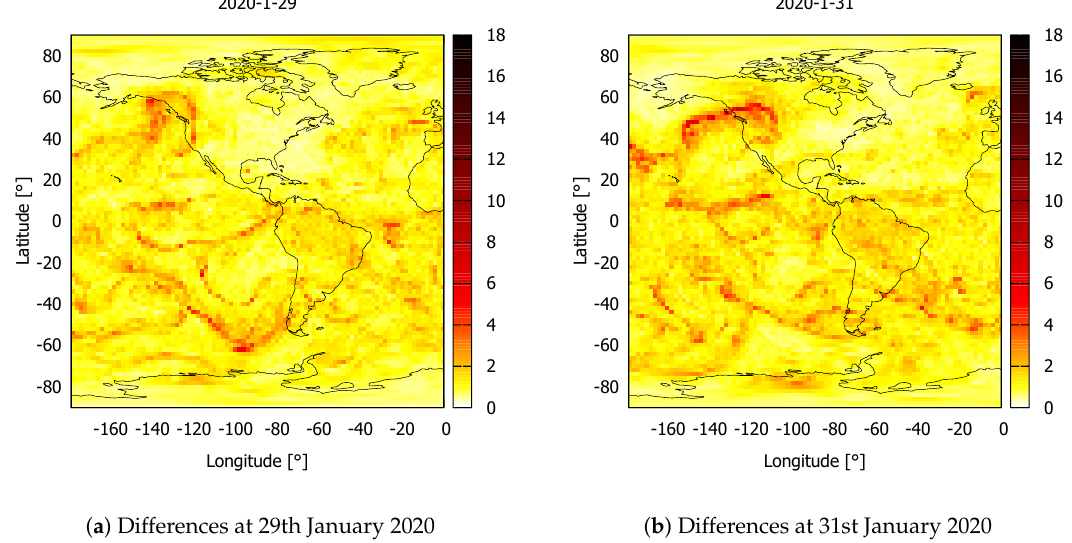
Figure 4. Standard deviation of 21 six-hour GEFS forecasts for the 29th ( a ) and 31st ( b ) January 2020. On a global average, the ensemble mean wind speed scatters 6 ms − 1 around the